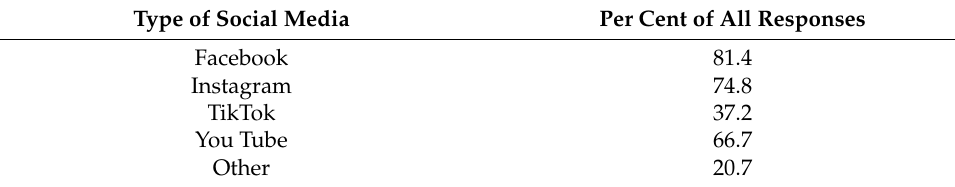
Table 2. Gen Z representatives and types of social media.